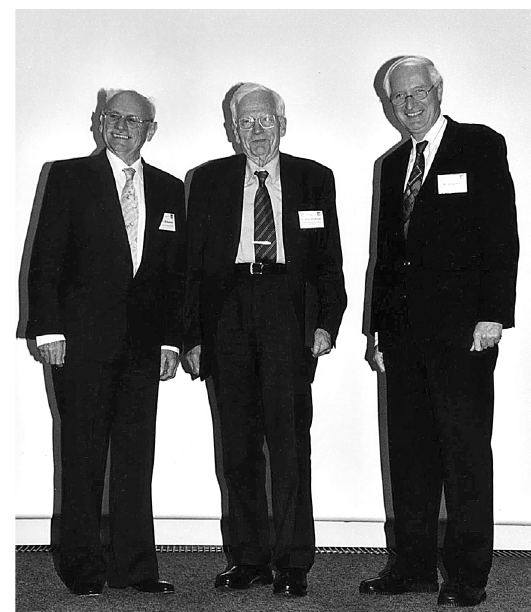
Figure 1 (left above): Prof. Schwarzl, Prof. Janeschitz-Kriegl and Prof. Wagner (left to right).